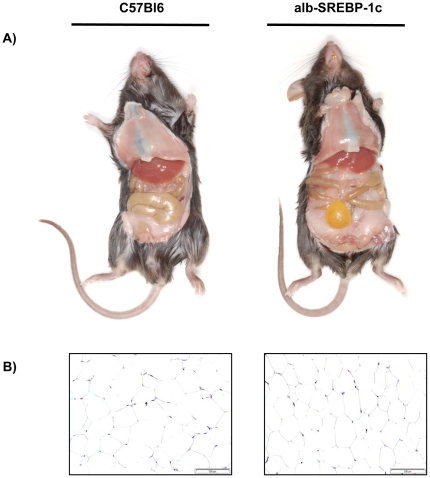
Macroscopic comparisons of C57Bl6 and transgenic alb-SREBP-1c animals.(A) First, sections of male mice at 24 weeks of age are shown. (B) Histology of visceral adipose tissue indicated hyperplasia but no signs of infiltration. All photographs were taken with the same magnification.